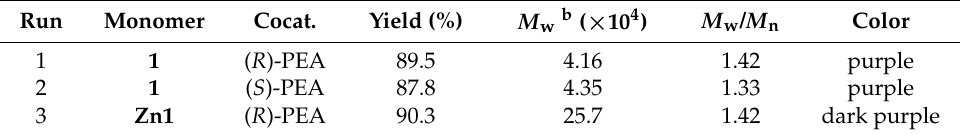
Table 1. Polymerization results of phenylacetylene having porphyrin moiety a . Run Monomer